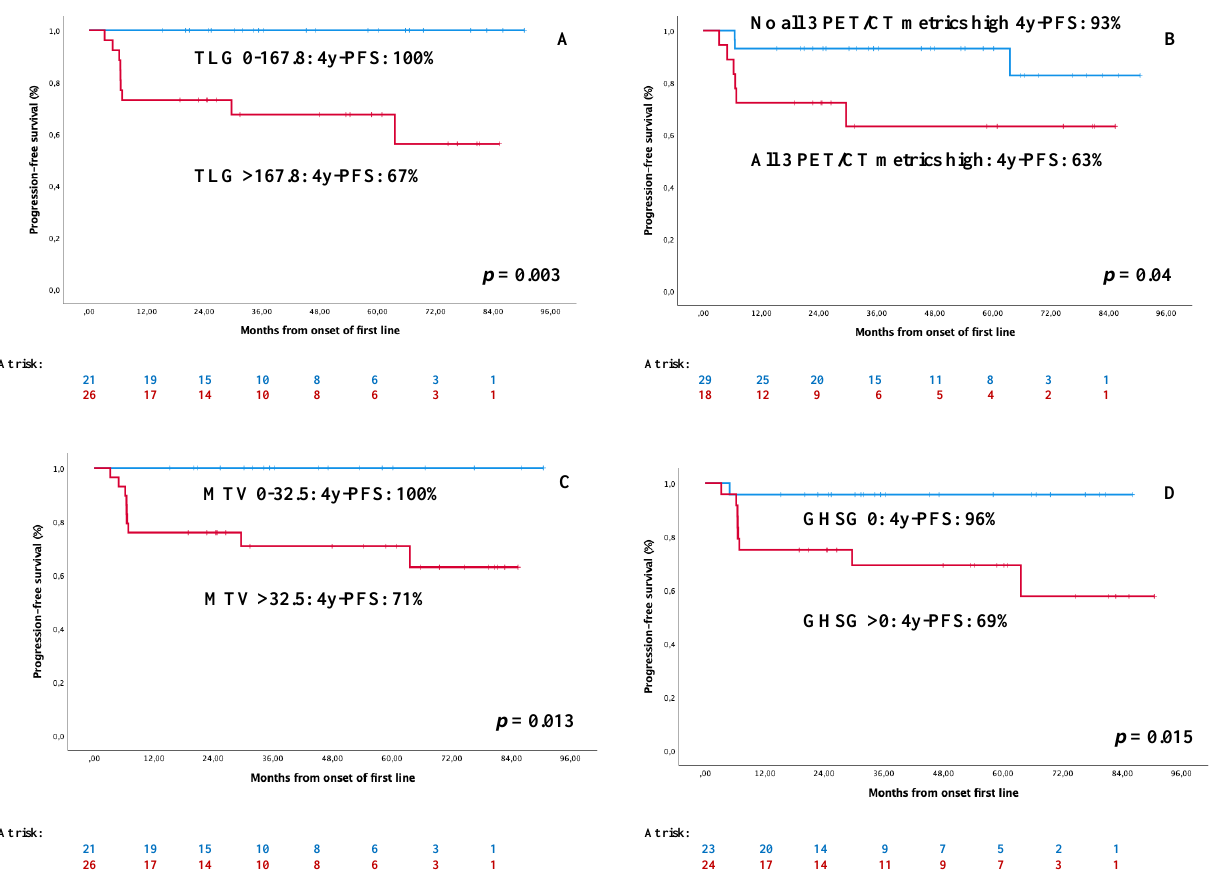
Figure 2. Impact on PFS of GHSG and PET/CT-related tumor-load assessments in I–II AA stages. ( A ) PFS according to TLG; ( B ) PFS according to all three PET/CT metrics; ( C ) PFS according to MTV; ( D ) PFS according to GHSG at